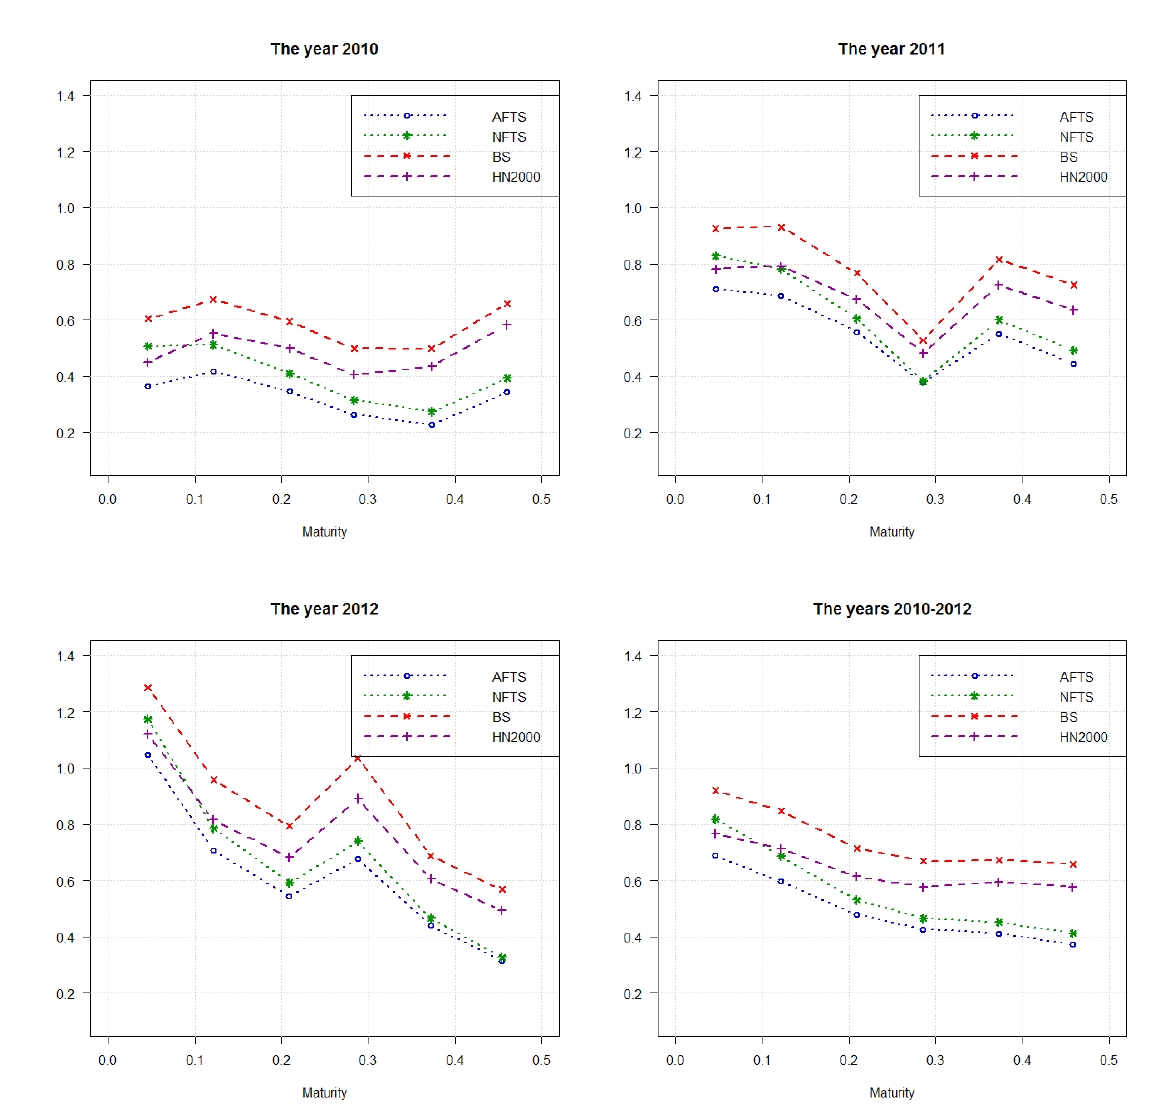
Figure 3. In-sample average absolute errors as a function of